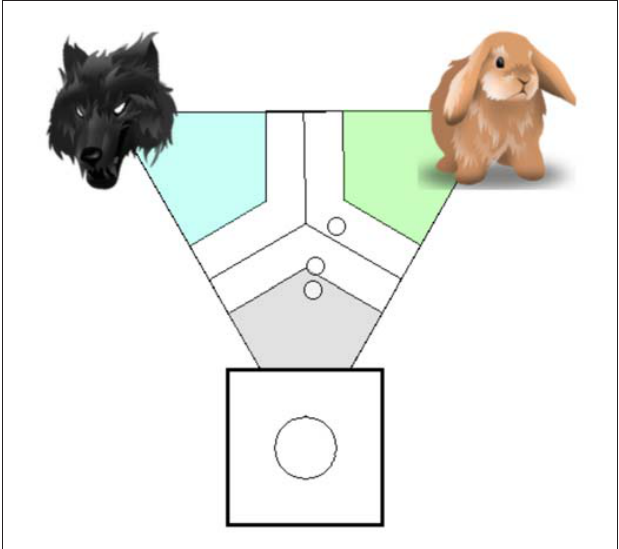
FIGURE 7 | Visualization system of Kosmyna et al. (2015). Large circle that corresponds to classification outcome and several small circles that correspond to the distance n-tuples that led to that classification outcome. Figure is reproduced with permission from the copyright